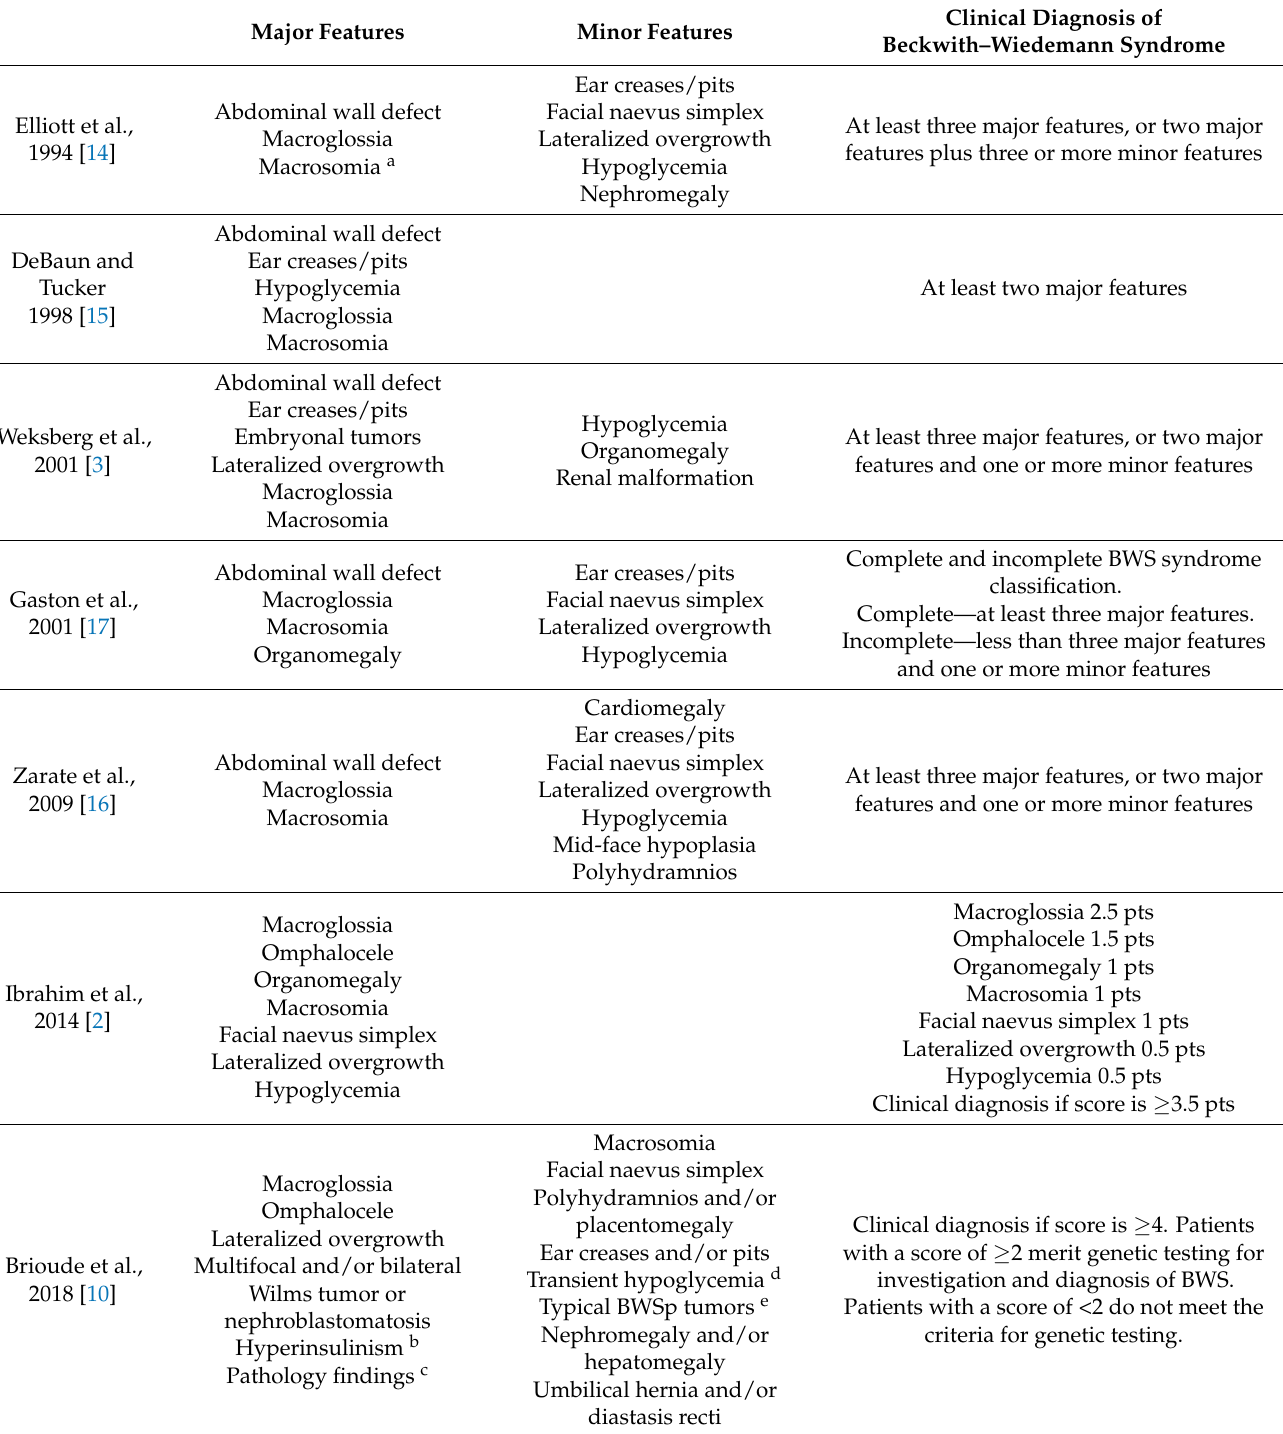
Table 1. Beckwith–Wiedemann syndrome (BWS) and spectrum (BWSp) clinical diagnostic criteria proposed over time by several